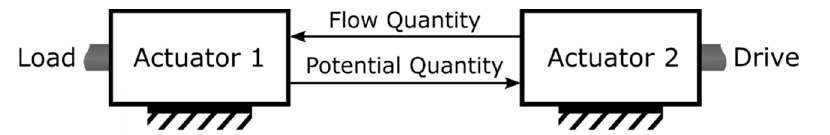
Figure 2. Virtual Coupling of mechanical subsystems [22].